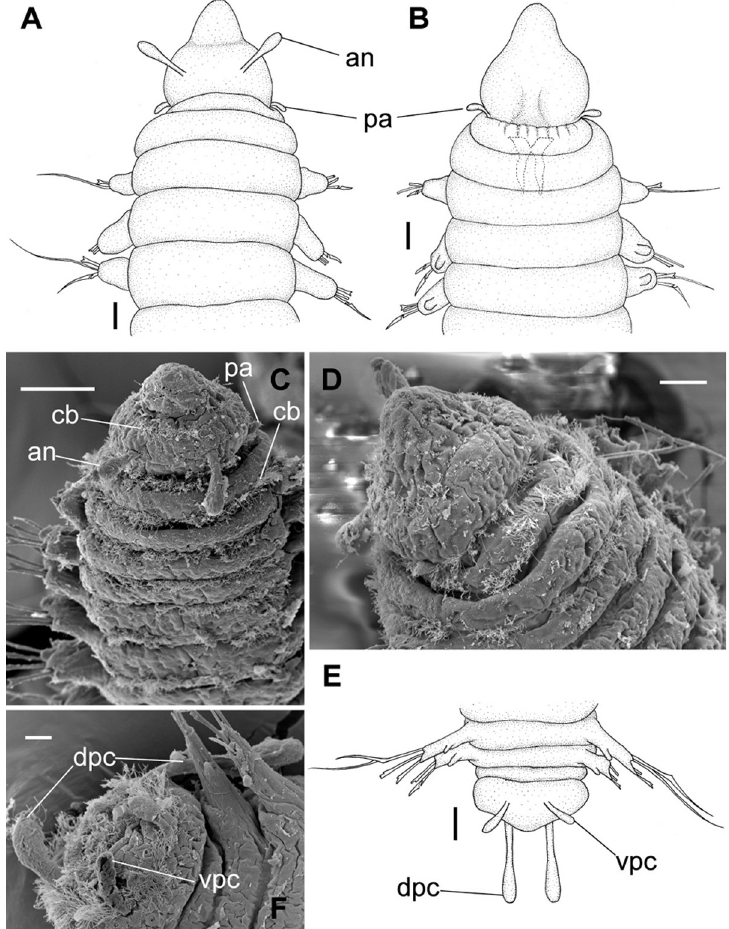
pa = palp; vpc = ventral pygidial cirrus. Scale bars: (A,B,E) = 25 μ m; (C) = 50 μ m; (D) = 20 μ m; (F) = 10 μ